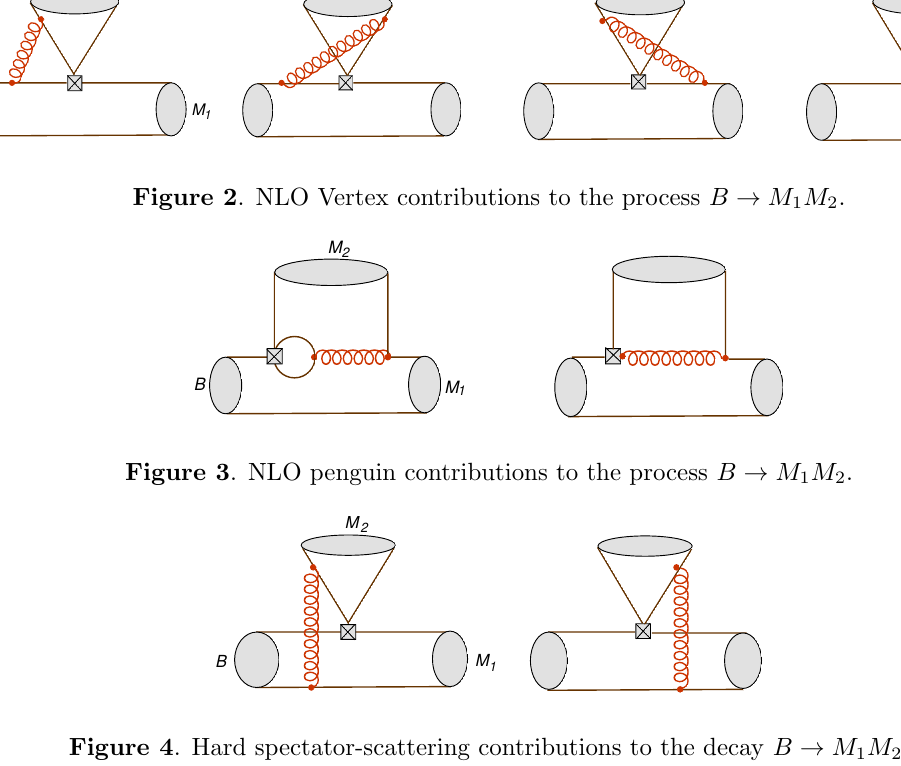
Figure 4 . Hard spectator-scattering contributions to the decay B ! M 1 M 2